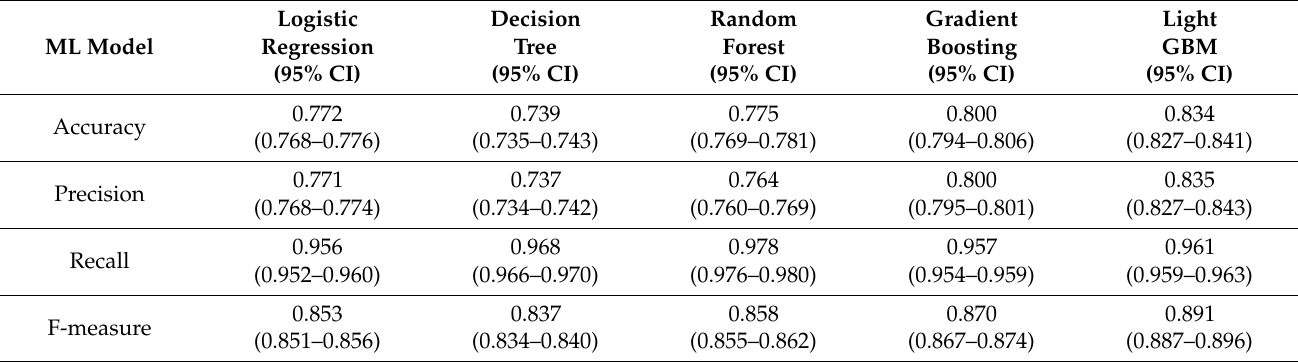
Table 4. Summary of the predictive results of each model.